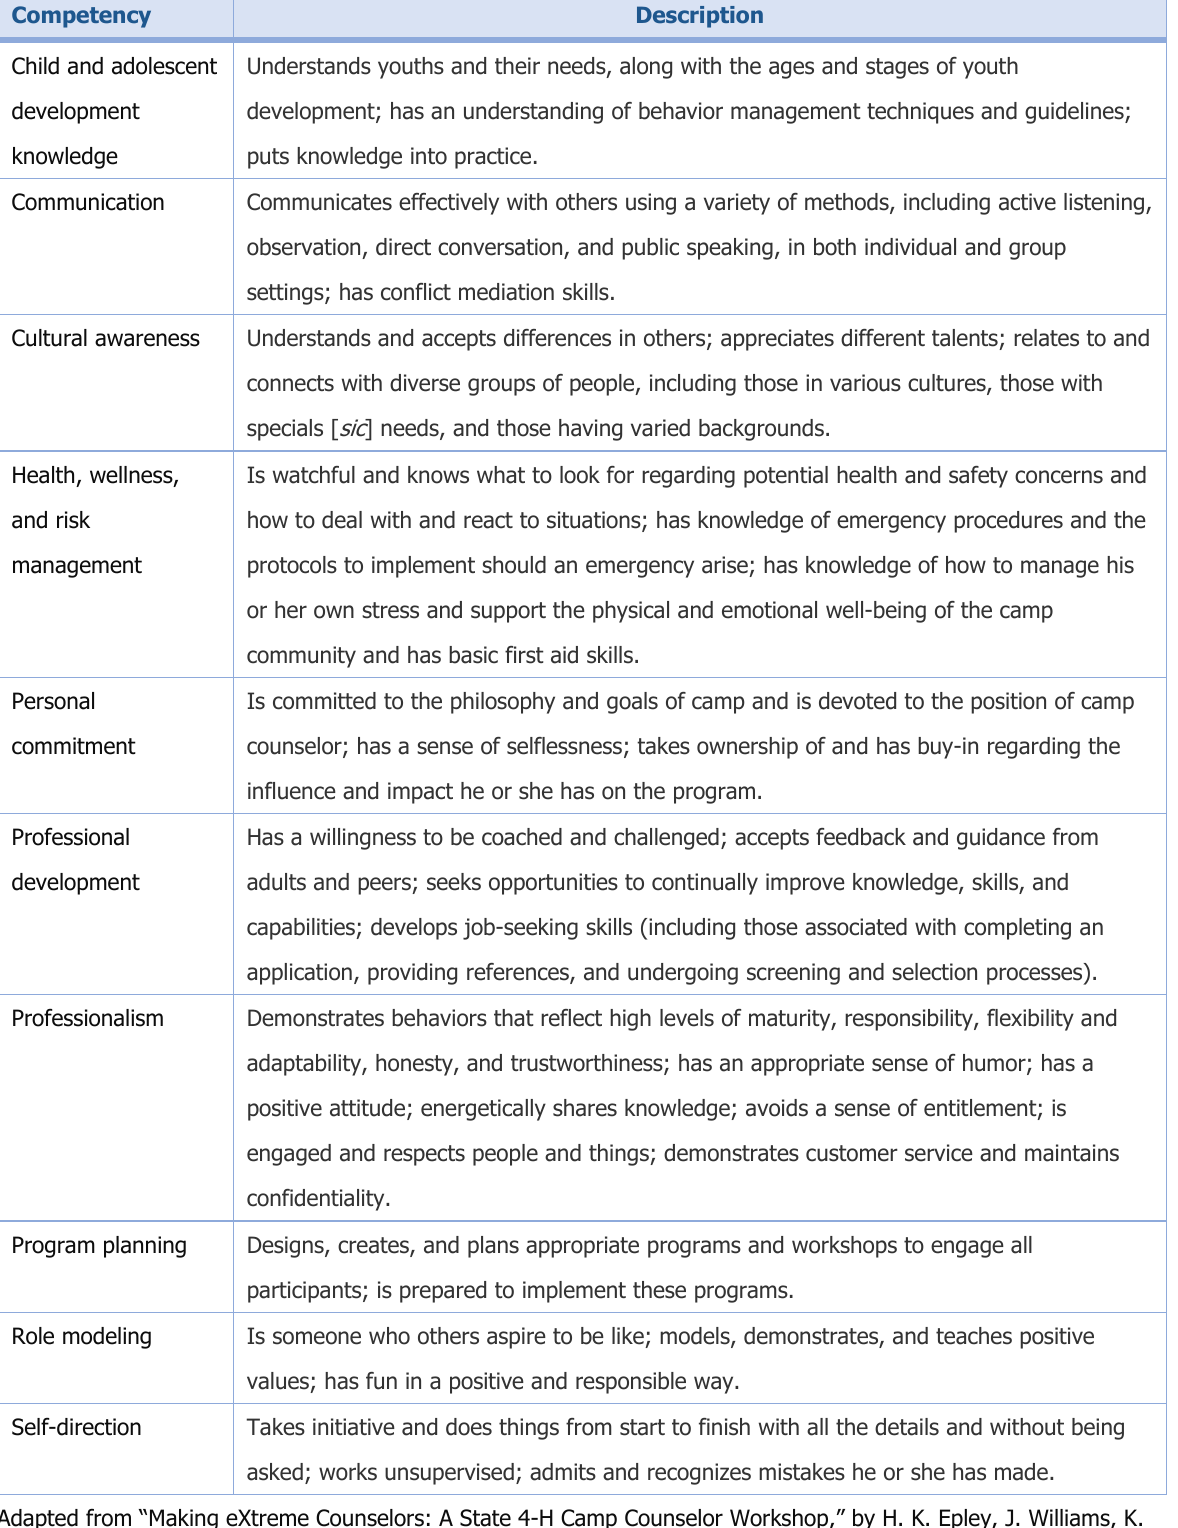
Table 1. Ohio 4-H Camp Counselor Competency Model